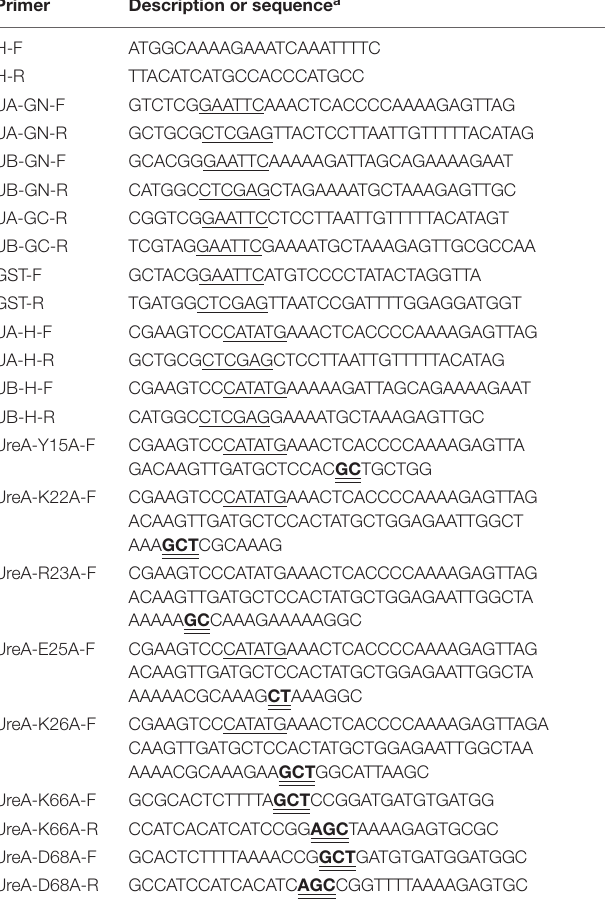
TABLE 1 | Primers used in this